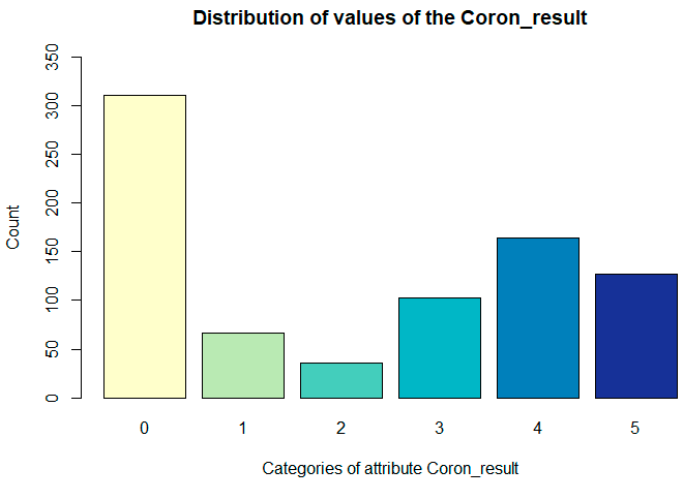
Figure 1. Representation of values Coron_result (the degree of severity of the coronarography finding) attribute.